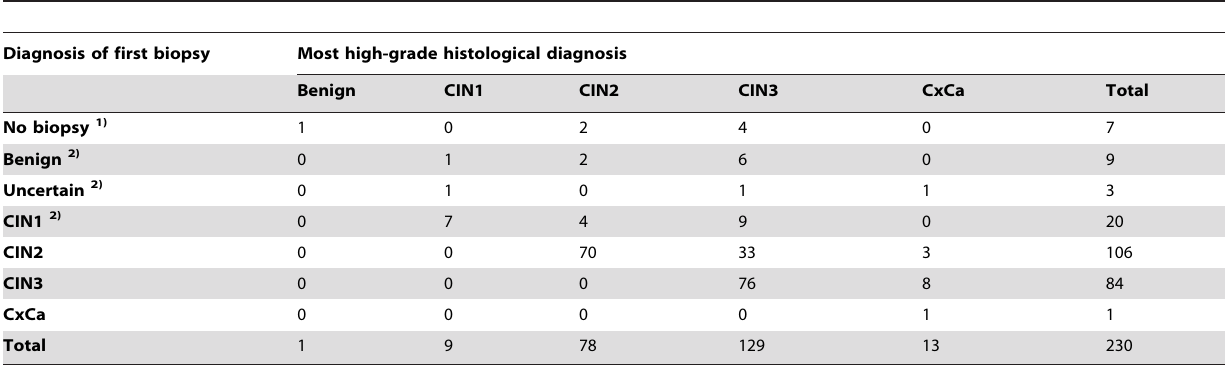
Table 5. HPV mRNA positive women with definite treatment: Diagnosis of first biopsy compared to the most high-grade histological